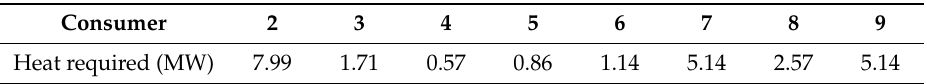
Table 1. Heat required (MW) for each consumer.